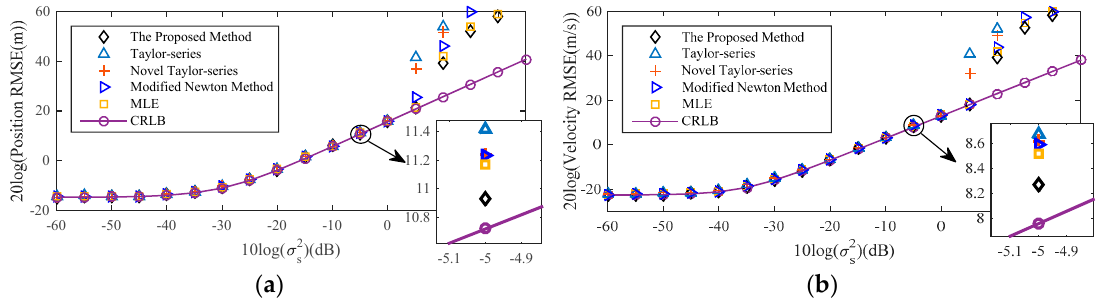
Figure 8. RMSE Comparison among different methods for the near-field source. ( a ) Position RMSE; ( b ) Velocity RMSE.